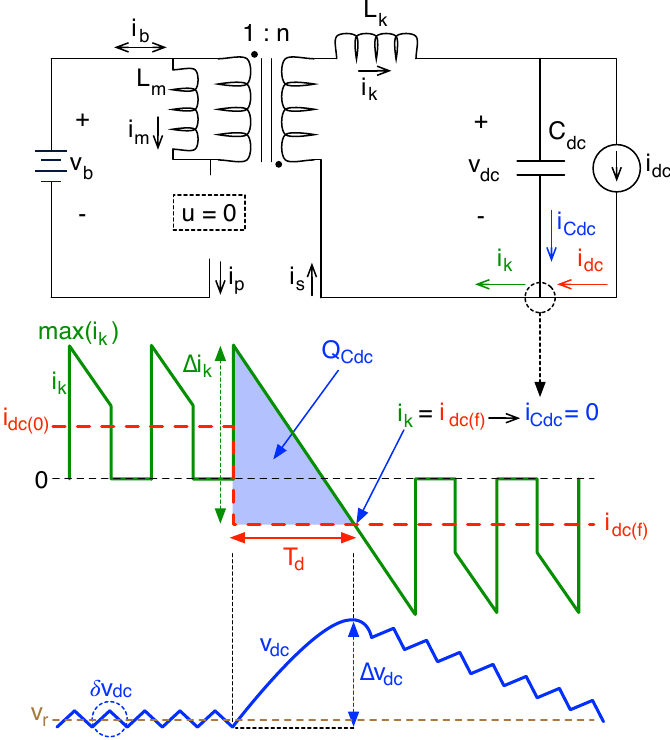
Figure 4. Example of a bus voltage deviation due to fast current